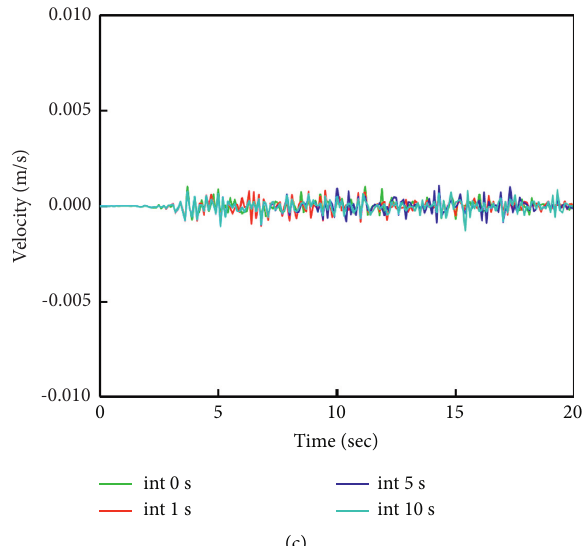
Figure 15: Time-history curves of the peak vertical vibration velocities at different measuring points with different time intervals (for the vertical arrangement): (a) 50m measuring point, (b) 100m measuring point, and (c) 200 m measuring point. V, V3 +3.6e+00 +5.0e-02